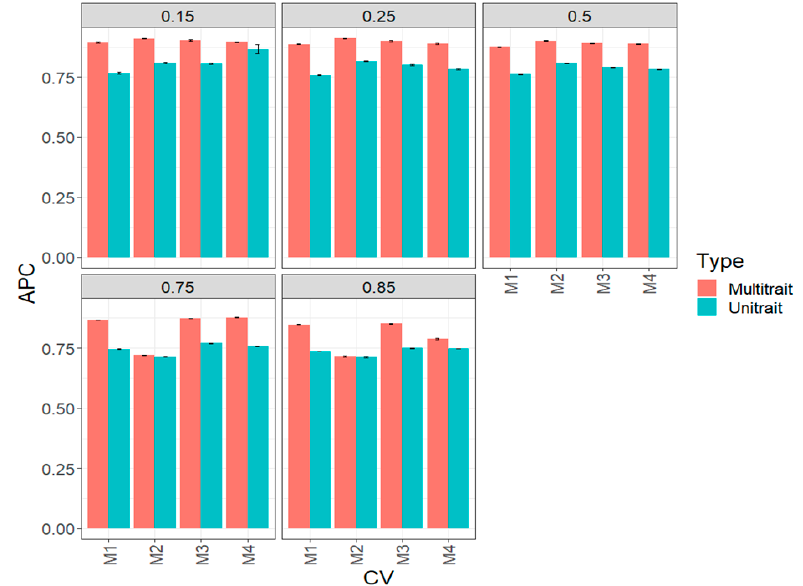
Figure 2. Prediction performance for the complete (big) maize data set in terms of average Pearson’s correlation (APC) of the four methods of sparse testing (M1, M2, M3 and M4) under unit-trait and multi-trait models for 5 percentages of testing: 15% (0.1), 25% (0.25), 50% (0.5), 75% (0.75) and 85%